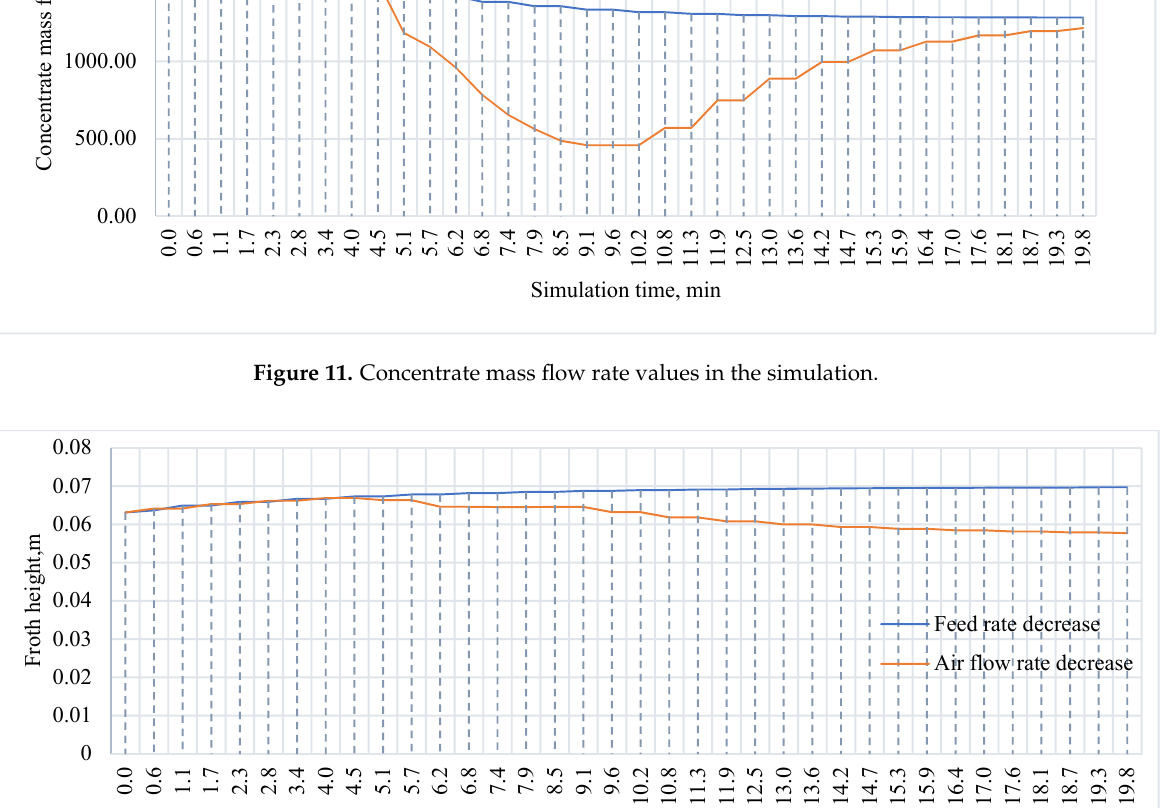
Figure 13. FeS 2 concentrate recovery values in the simulation. Figure 14. FeS 2 concentrate grade values in the simulation.